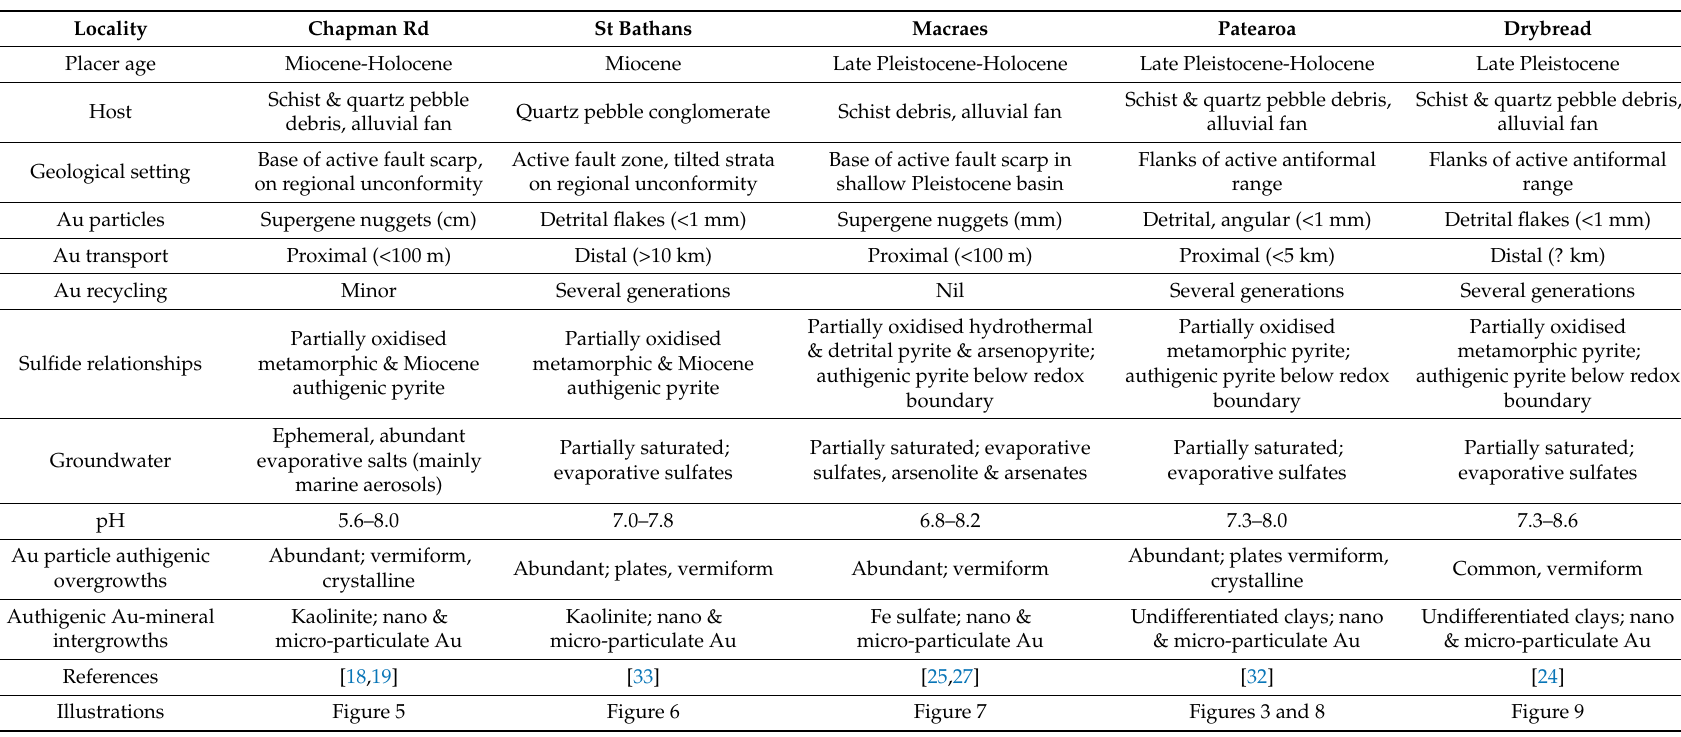
Table 1. Summary of the key geological and mineralogical features of gold-bearing localities described in the text, with principal biologically-mediated authigenic gold